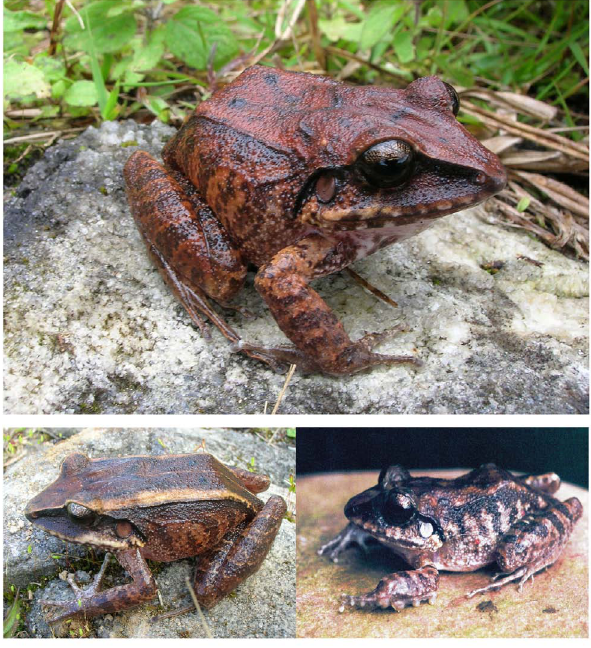
Figure 1. Strabomantis aramunha Living specimens of from the state of Bahia, Brazil. Above, UFBA 6221, adult female, SVL 66.1 mm; underneath left, UFBA 6222, SVL 64.0 mm, adult female, showing a dorsal color pattern characterized by two cream longitudinal dorsolateral stripes; both specimens from the Parque Estadual das Sete Passagens, municipality of Miguel Calmon (photos by Rafael O. Abreu).